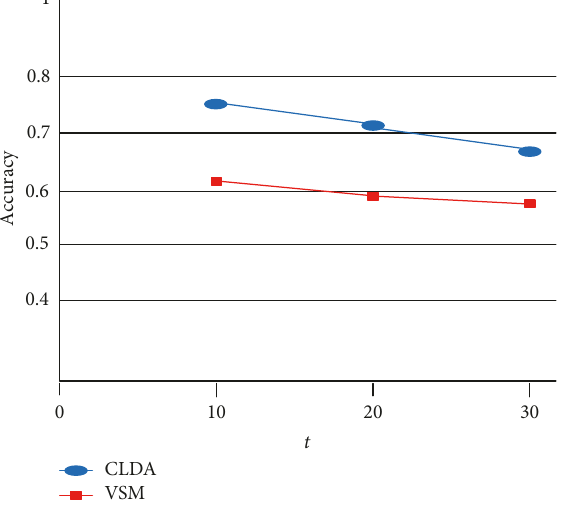
Figure 5: Recommended accuracy in education field.